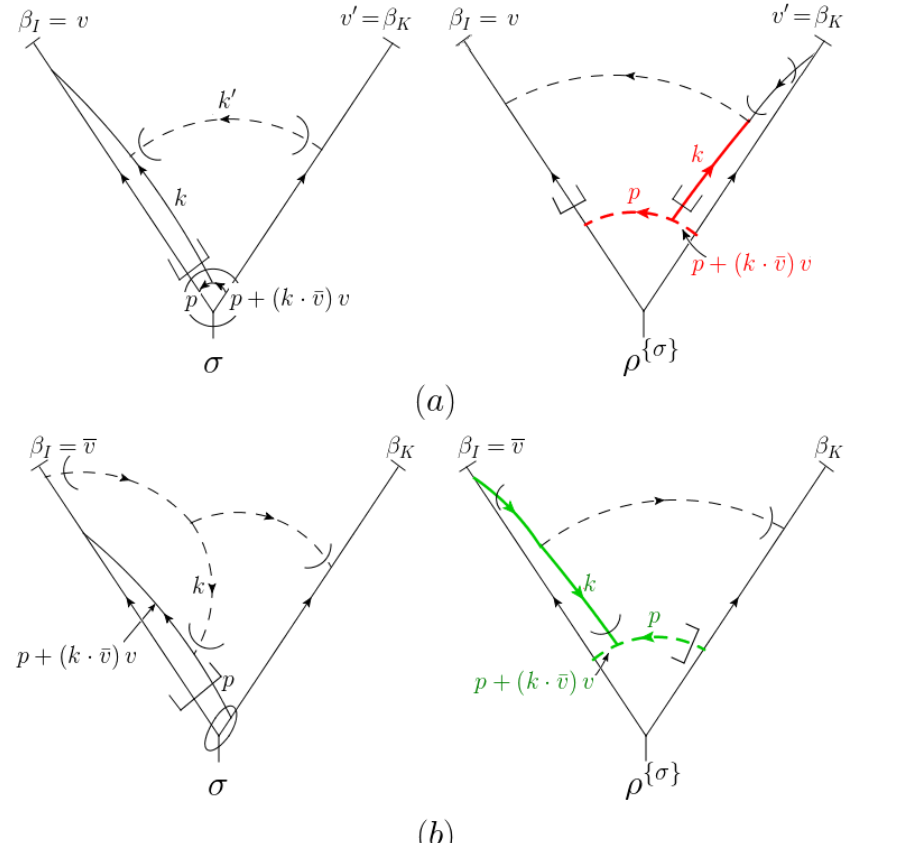
Figure 7. Two examples of case (Ciii), where a jet propagator can end at a soft vertex in (cid:26) f (cid:27) g . In the upper row ( a ), t (cid:27) acts as a hard-collinear approximation and only keeps the v (= (cid:12) I )-component of k (cid:22) in H ( (cid:27) ) . At the same time, it also acts as a soft-collinear approximation on the soft momentum entering J ( (cid:27) ) . When this soft line in (cid:27) becomes collinear to v 0 (cid:22) (= (cid:12) (cid:22) ) in (cid:26) f (cid:27) g , for the same reasons I K as in (Bii) above, k (cid:22) is pinched in the direction of v (cid:22) . Then ( k (cid:1) v ) v (cid:22) vanishes at the pinch surface (cid:26) f (cid:27) g , and if the internal momentum p (cid:22) is soft as well, all the incoming momenta at the con(cid:13)uence of p (cid:22) and ( t (cid:27) k ) (cid:22) will be soft. In the lower row ( b ), t (cid:27) acts as a soft-collinear approximation on k (cid:22) , and projects it onto its v (= (cid:12) )-component. Subsequently, a soft vertex forms when k (cid:22) is collinear I to v (cid:22) (= (cid:12) (cid:22) ). The encircled propagators are hard, and the propagators marked red or green are for I later uses in section